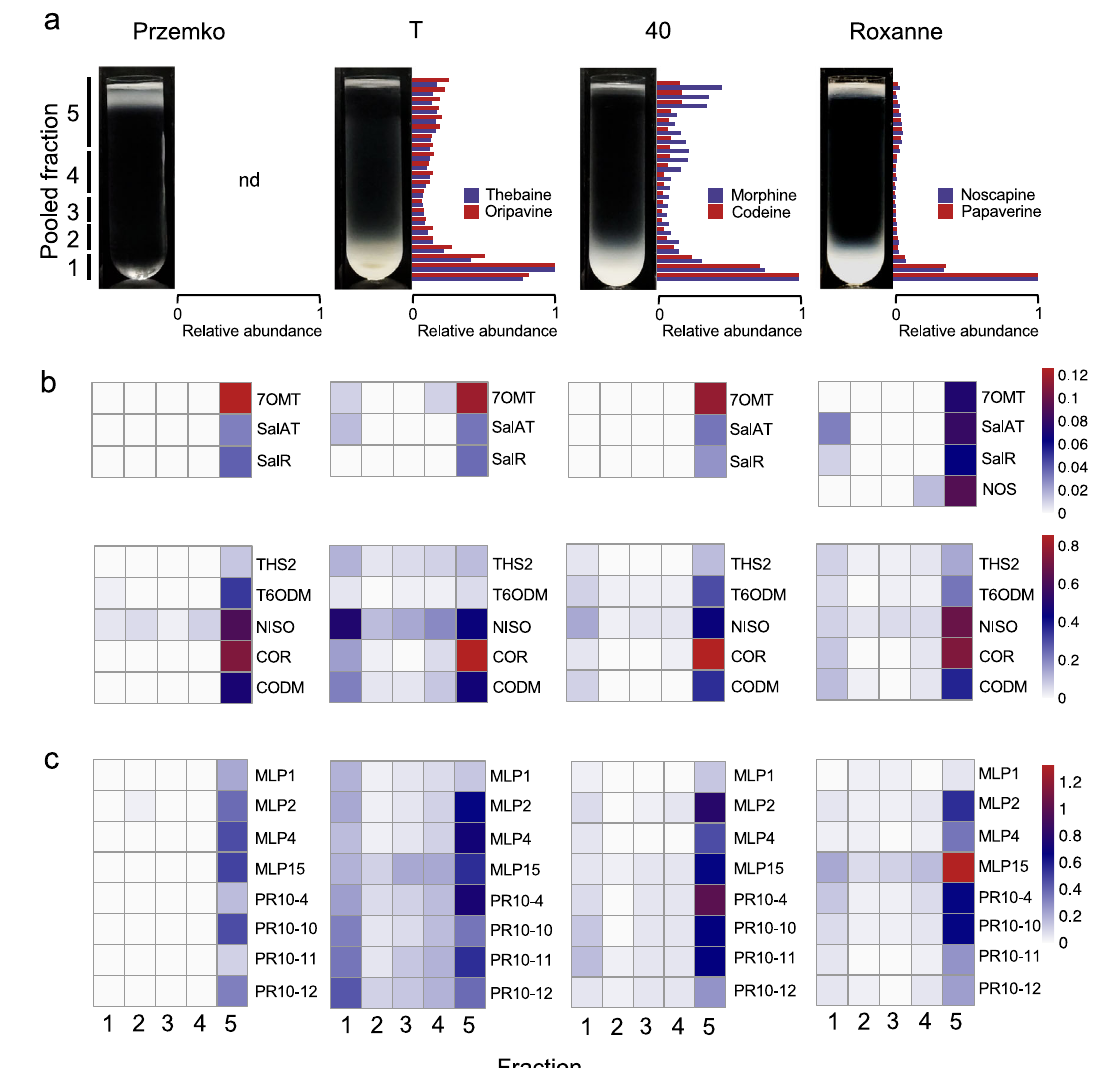
Fig. 1 | Sucrose-gradient analysis of opium poppy latex. a Images of sucrose density gradients run with Przemko, T, 40 or Roxanne latex, and the relative abundance of selected BIAs in gradient fractions (blue and red bars). The pooled fractionsusedforshotgunproteomicsareindicatedontheleftside.Alkaloidlevels werenormalizedtothefractionwiththegreatestabundance. b Heatmapsshowing the relative abundance of BIA biosynthetic enzymes in proteomes of pooled